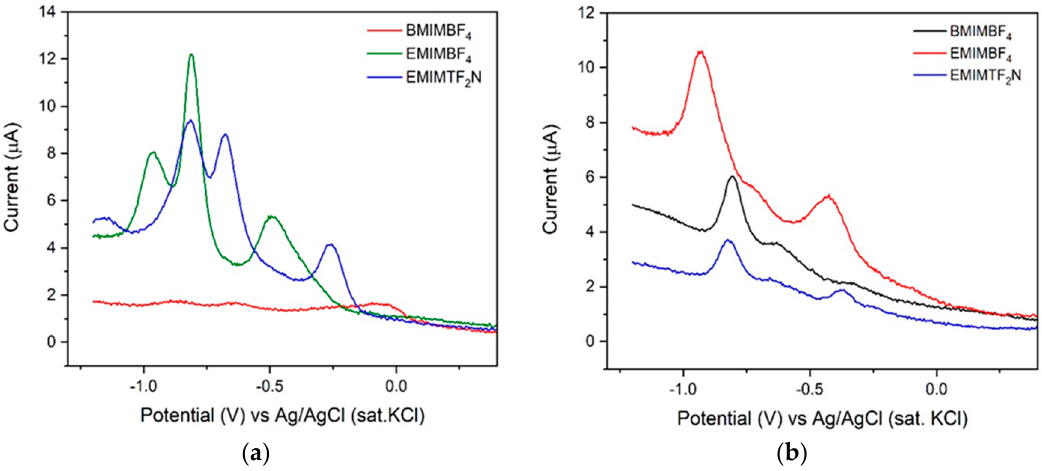
Figure 4. Square wave voltammetry has been performed using RTIL-modified GCE in two different analytes with a frequency of 25 Hz, amplitude of 25 mV and step size of 5 mV. ( a ) SQWV of different RTIL@GCE for ( a ) 2,6 DNT ( b ) ENB, showing higher peak current for [EMIM][BF 4 ].